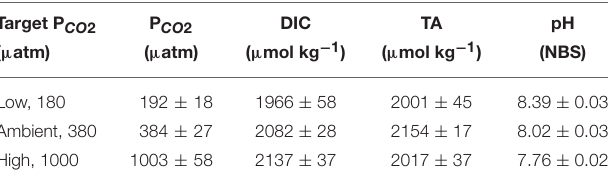
TABLE 1 | Dissolved inorganic carbon concentrations (DIC) and partial pressure of CO 2 (pCO 2 ) were calculated from total alkalinity (TA), pH, silicate, phosphate, temperature, and salinity using the CO2Sys program (Pierrot et al.,